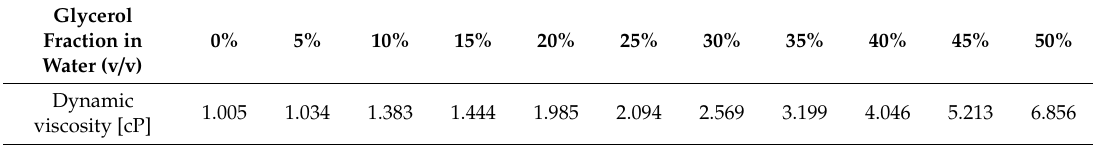
Table 1. Dynamic viscosity of the glycerol fraction in Milli-Q water.